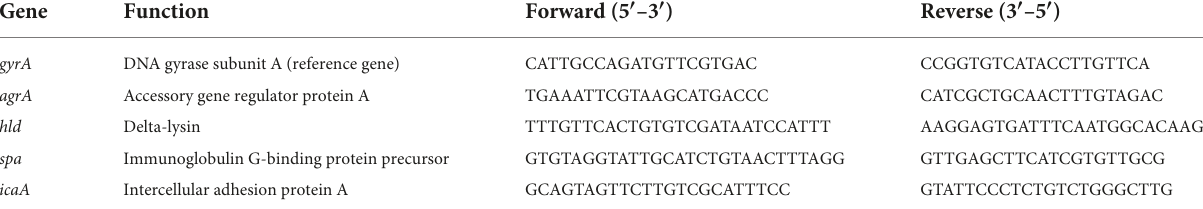
TABLE 1 Primers used for the ddPCR